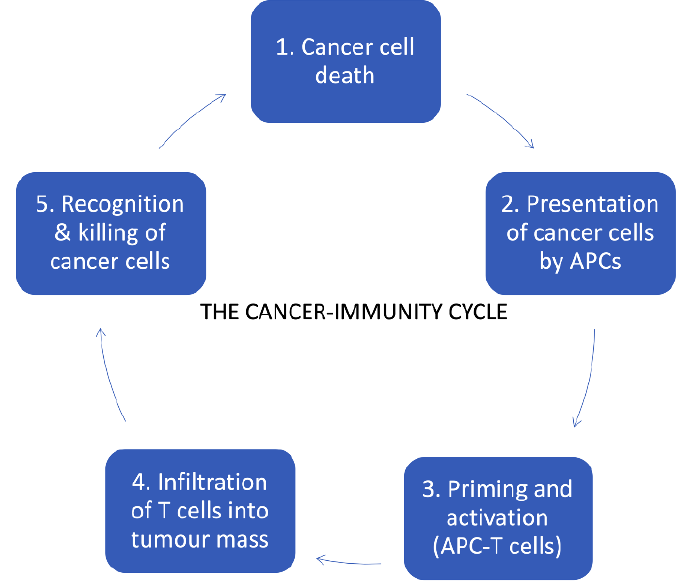
Figure 1. The cancer immunity cycle, modified from [42].